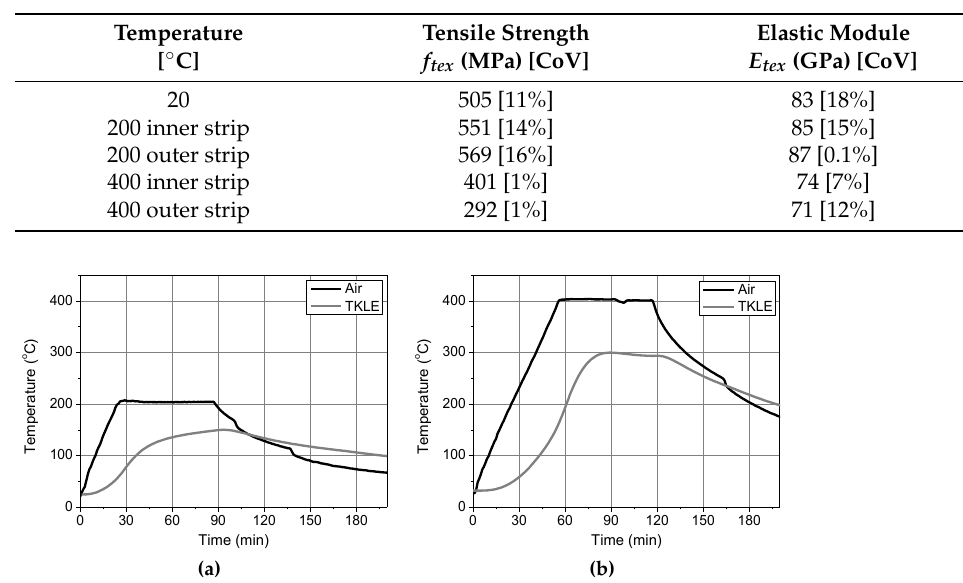
Figure 5. The temperature profiles as recorded by thermocouples during heating at ( a ) 200 °C and ( b ) 400 °C .